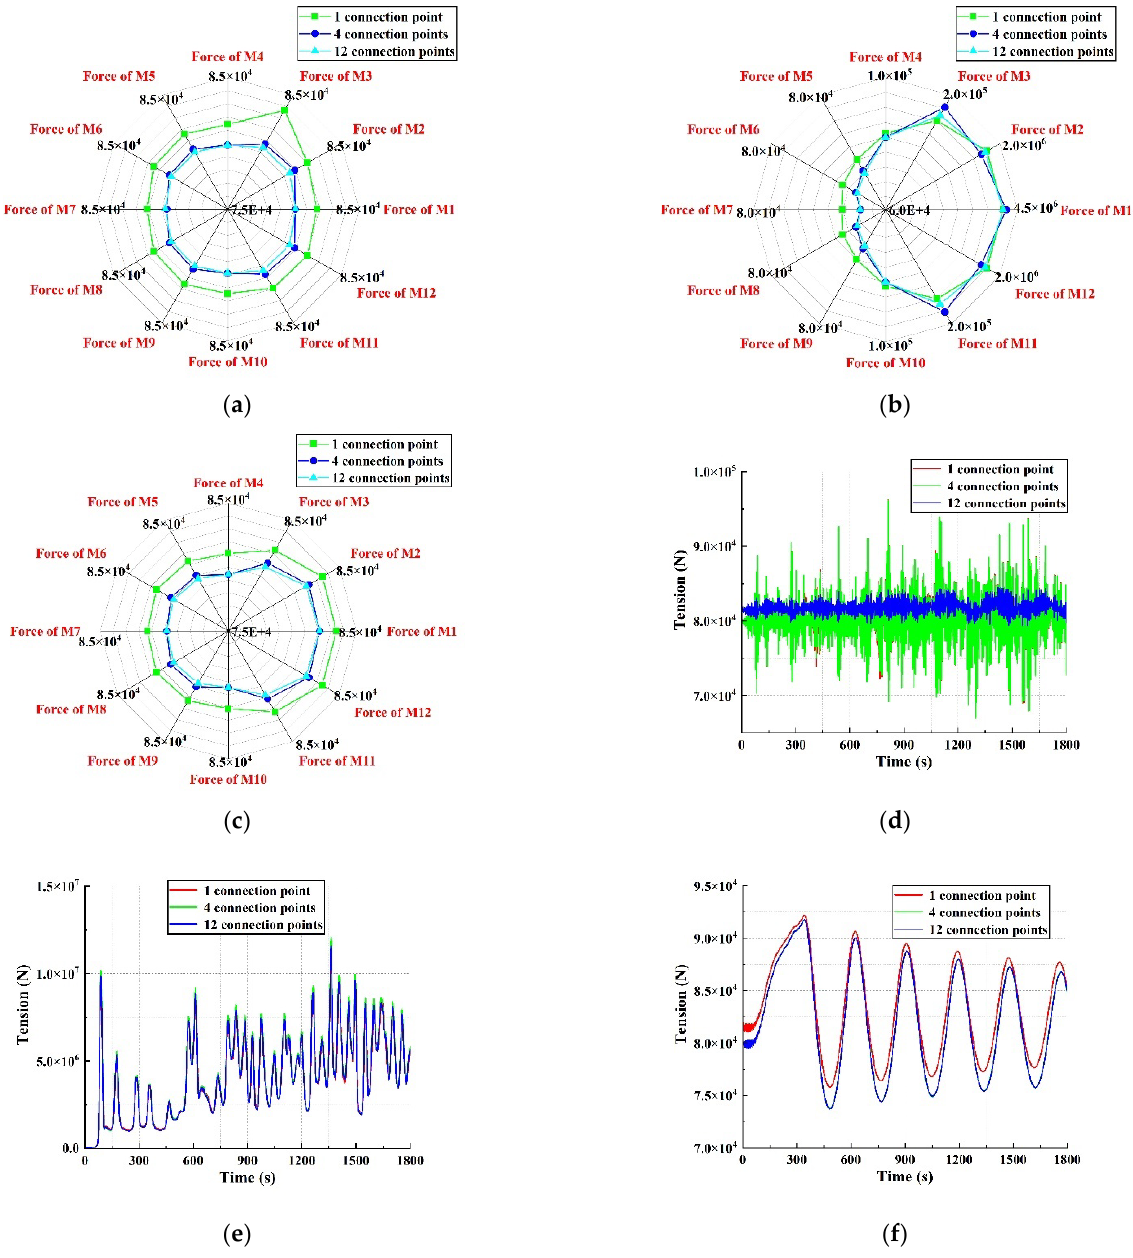
Figure 19. Influence of the number of connection points on mooring line tension. ( a ) Mean tension of mooring lines under wave loads; ( b ) mean tension of mooring lines under level ice loads; ( c ) mean tension of mooring lines under broken ice floes loads; ( d ) the tension of mooring line 1 under wave load in time-domain analysis; ( e ) the tension of mooring line 1 under level ice load in time-domain analysis; ( f ) the tension of mooring line 1 under broken ice floes load in time-domain analysis.